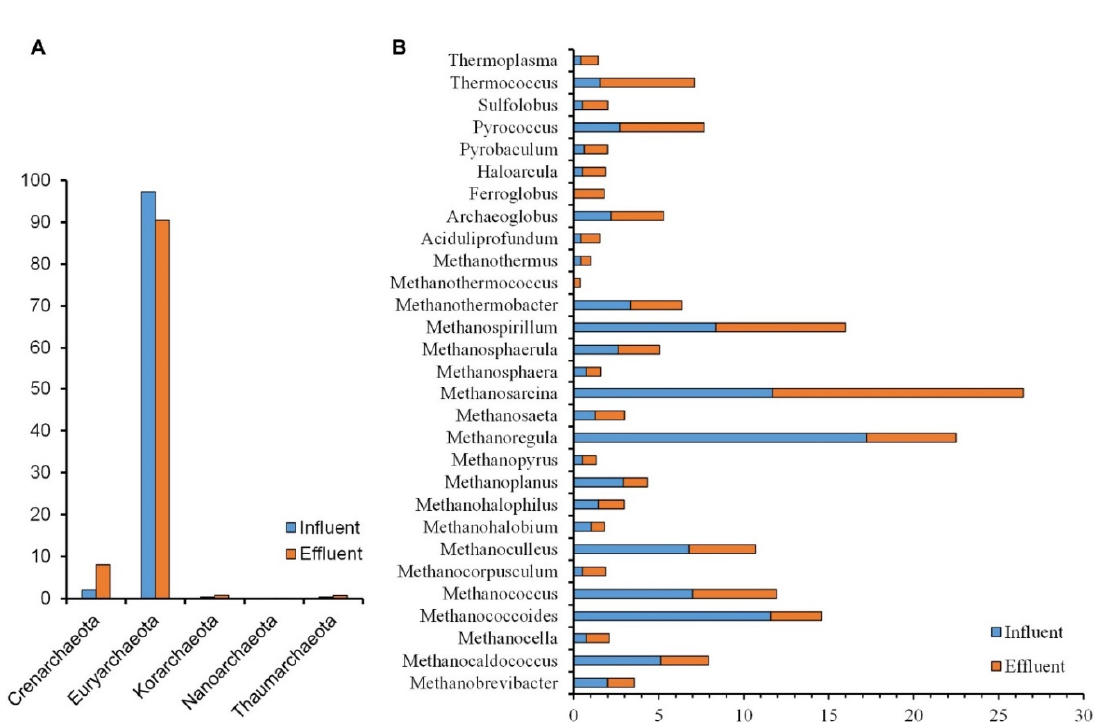
Figure 3. Taxonomic analysis of archaea associated sequence reads in the influent and effluent samples. Percent relative abundance of ( A ) phyla, and ( B ) genera identified methanogenic or detected in relatively higher abundance. The relative abundance was calculated by normalizing the sequence reads of each archaea taxon to the total number of archaea associated sequences reads in the respective metagenome.